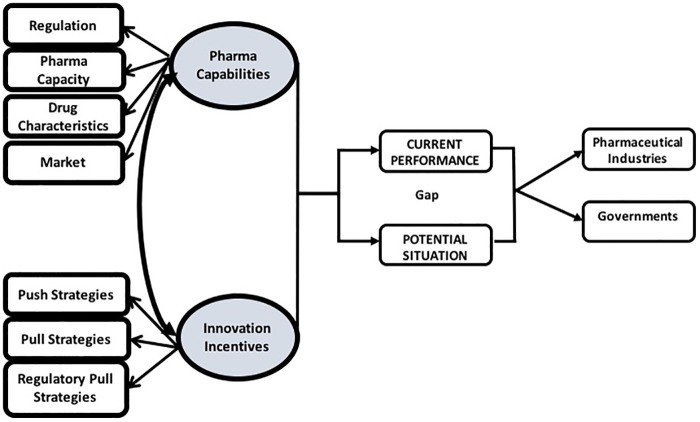
Conceptual model.